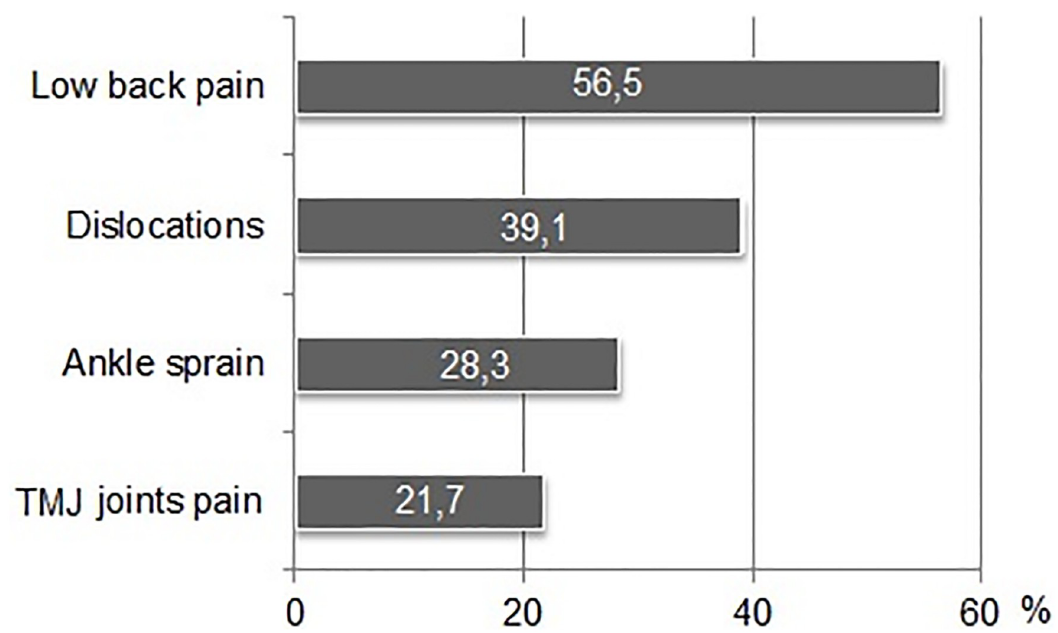
Fig 3. Percentage frequency distribution of the prevalence of JHS symptoms.